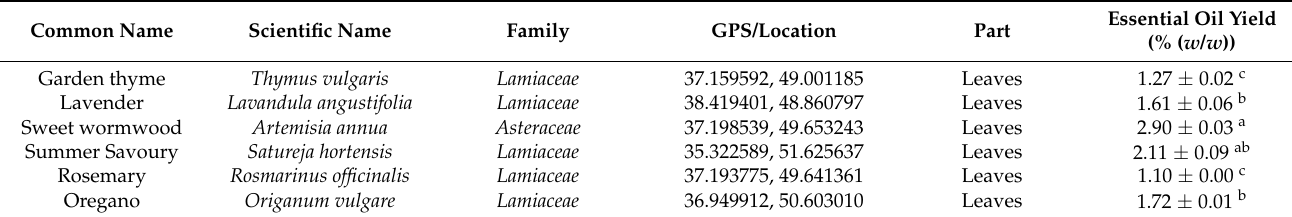
Table 1. List of plants used for exploring the ovicidal effect of their essential oils on elm leaf beetle